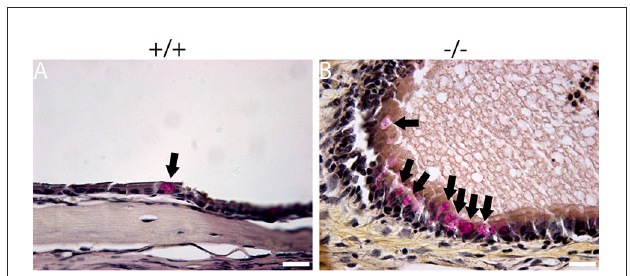
FIGURE6 Mucin staining reveals goblet cells in mutant mice. Representative sections show the presence of goblet cells (arrow) in the mucosa of the middle ear cavity of wild-type and mutant mice at the age of 2 months. (A) Goblet cells were found to be sparsely scattered among other cells in the mucosa of wild-type mice. (B) By contrast, goblet cells were present at high density among other cells in the mucosa of mutant mice. Scale bars: 20 µ m.